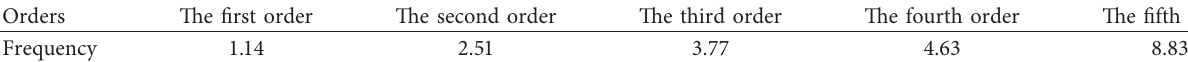
Table 2: Natural frequency (unit: Hz).